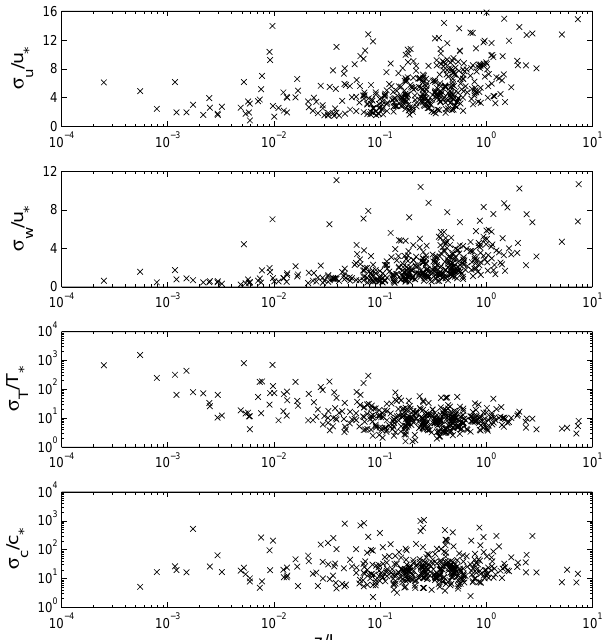
Fig. 3. Standard deviation of u , w , T , CO 2 concentration and temperature normalized by scale parameters ( u ∗ , c ∗ = w 0 T 0 T ∗ = − w ) and with z/L calculated using the 300-second recur- u ∗ sive filter. Here u and w are longitudinal and vertical wind com- ponents, respectively and T is air temperature. z is a measurement height and L ≡− u 2 ∗ / [ k(g/T )T ∗ ] is the Obukhov length.